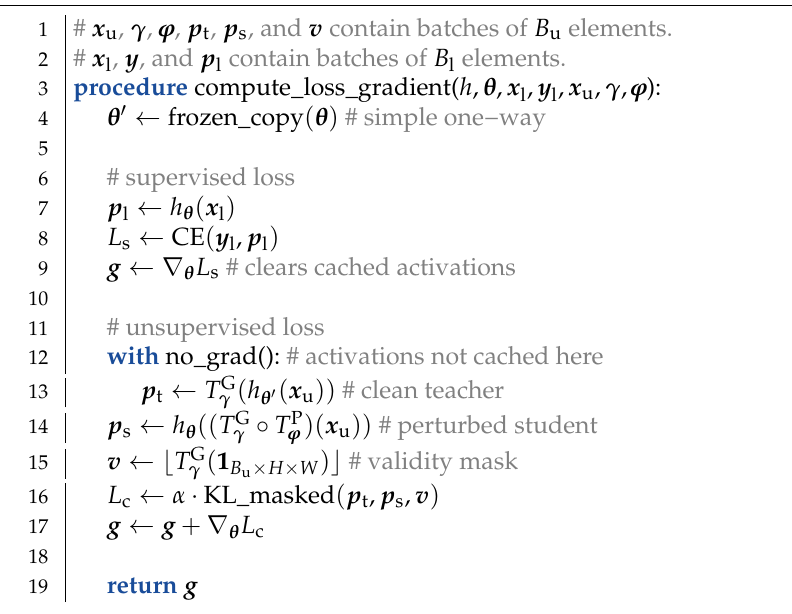
Algorithm 1. Evaluation of the gradient of the proposed semi-supervised loss given perturbation parameters ( γ , φ ) on a mixed batch of labeled ( x l , y l ) and unlabeled ( x u ) examples. CE denotes mean cross entropy, while KL_masked denotes mean KL divergence over valid pixels.